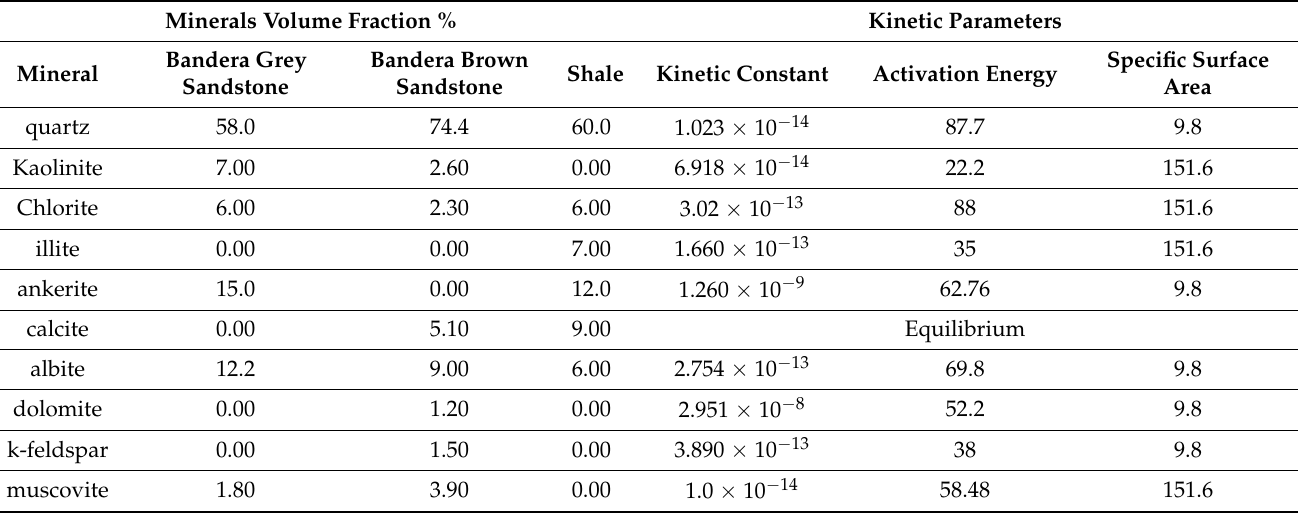
Table 1. The used mineral composition and kinetics parameters for the various rock types.